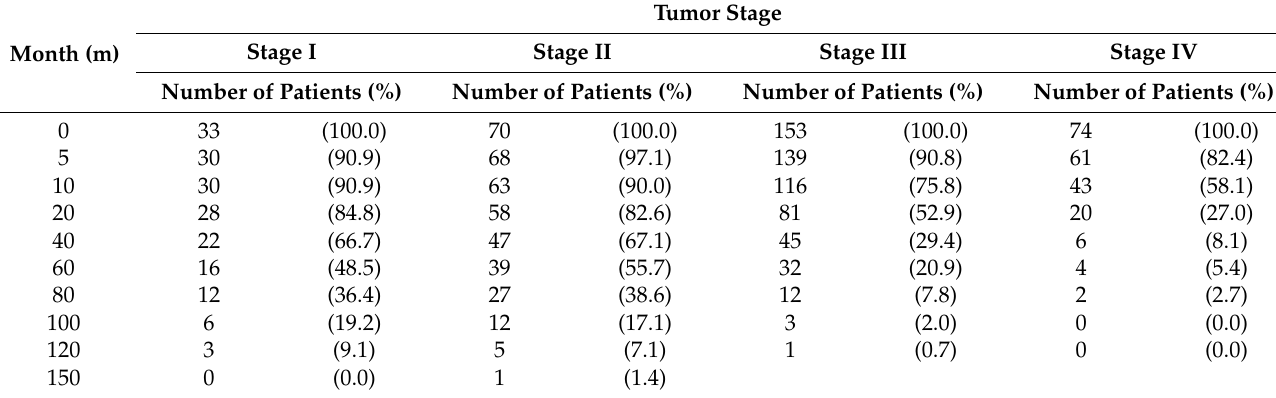
Figure 1. HSF1 expression was correlated with the overall survival of gastric cancer patients. Two probes (Affy ID: 202344_at, and Affy ID: 213756_s_at) revealed that high HSF1 expression leads to poor survival depending on gastric cancer patient stage. The Kaplan–Meier survival curves were generated using the KM-plotter online analysis tool. Table 2. Overall survival of gastric cancer patients with high HSF1 expression according to the diseases stage (HSF1 probe: Affy ID: 202344_at ).